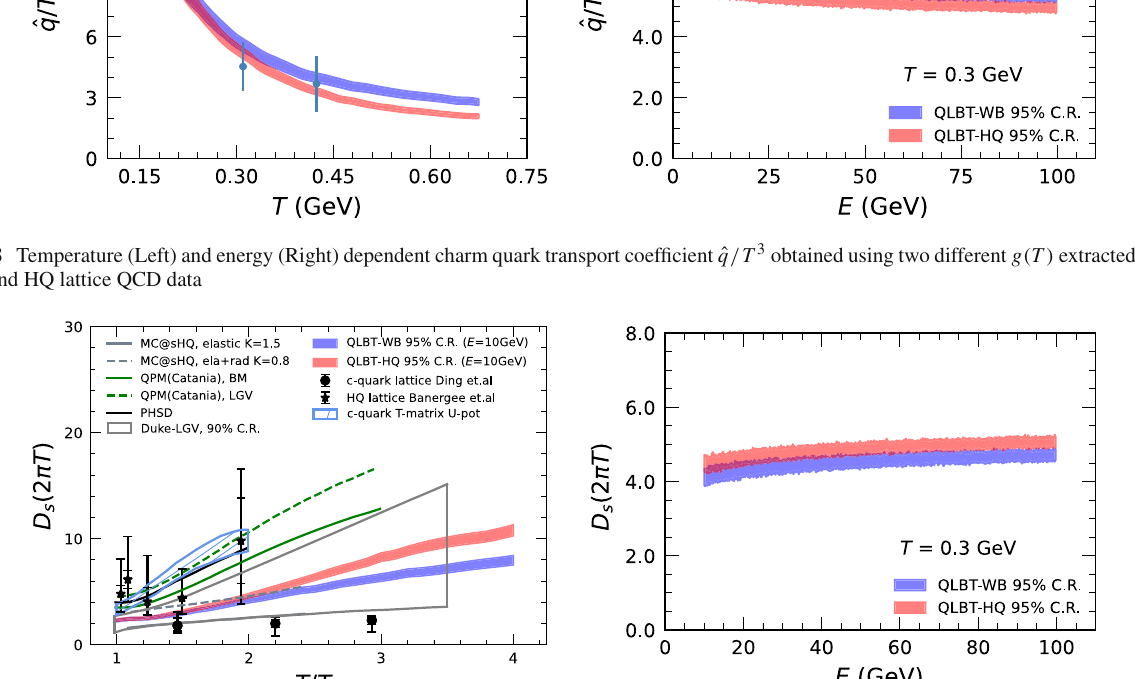
based on the previous linear Boltzmann transport